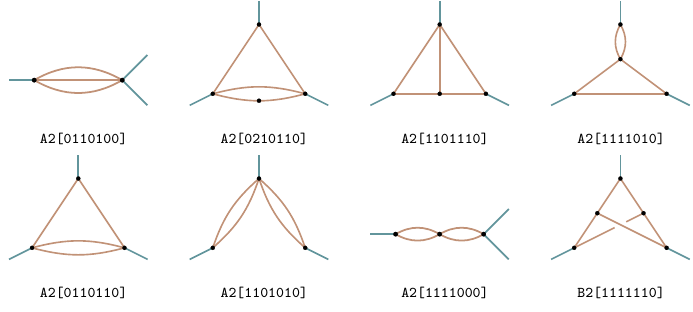
Table 4 . One-loop master integrals.